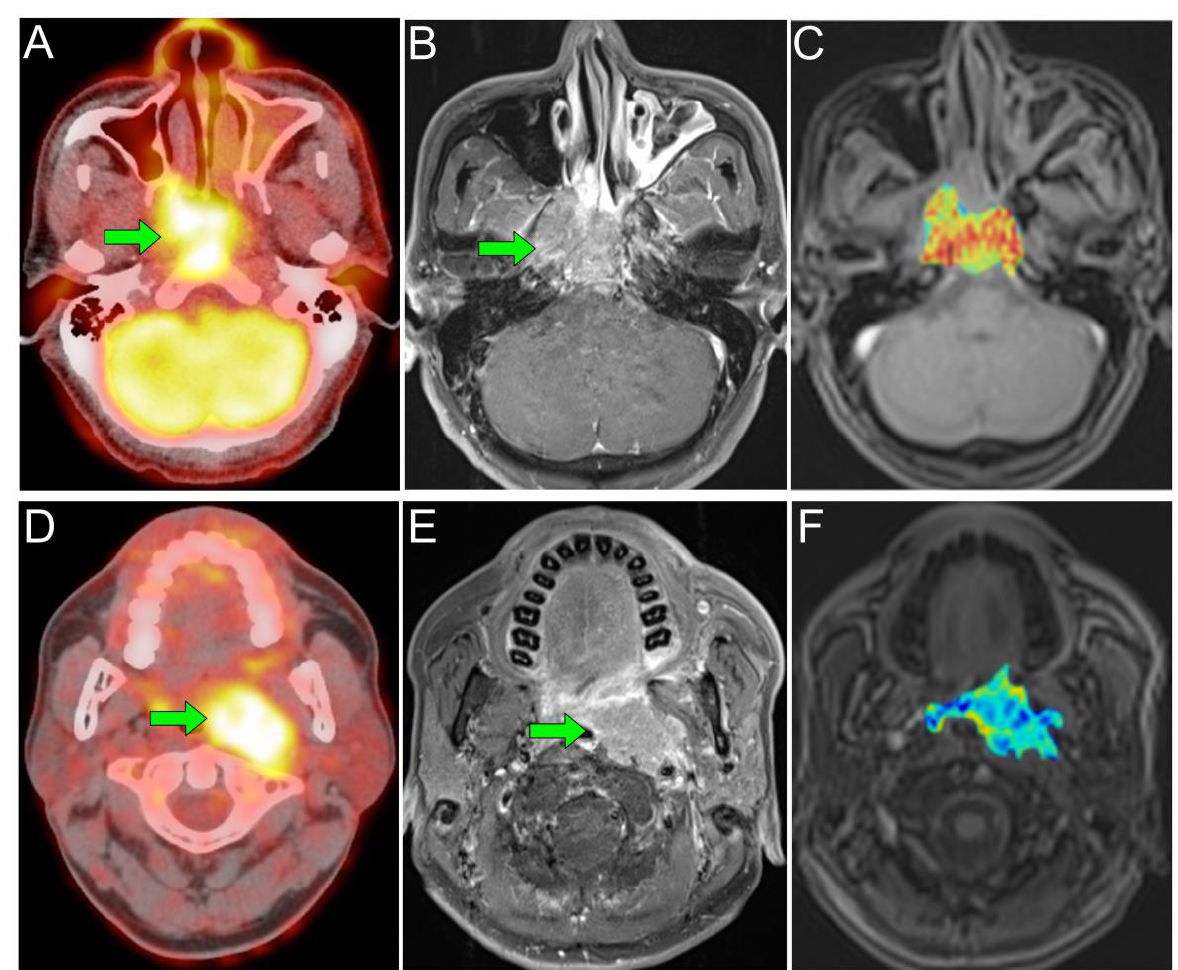
Figure 3. Cases with different combinations of TLG and iAUC. ( A – C ) Representative axial PET or MRI images of a primary NPC patient with T4N1 disease. ( A ) 18 F-FDG PET/CT image; ( B ) contrast-enhanced T1-weighted MR image; and ( C ) an iAUC color map. This patient had a low TLG of 130.14 g/mL × mL and a high iAUC of 734.94. He survived without disease recurrence for 6.04 years after diagnosis. ( D – F ) Axial PET and MRI images of a primary NPC patient with T3N1 disease. This tumor extended downward to the oropharynx. ( D ) 18 F-FDG PET/CT image; ( E ) contrast-enhanced T1-weighted MR image; and ( F ) an iAUC color map. He had a high TLG of 265.41 g/mL × mL and a low iAUC of 522.50. Despite concurrent chemoradiotherapy, this patient died of distant recurrence with a short overall survival period of 3.28 years. iAUC, initial area under the curve; TLG, total lesion glycolysis.